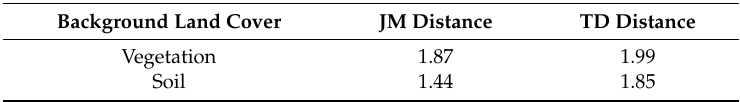
Table 4. Separability between ISA and background land cover in validation samples. JM: Jeffries–Matusita, TD: transformed